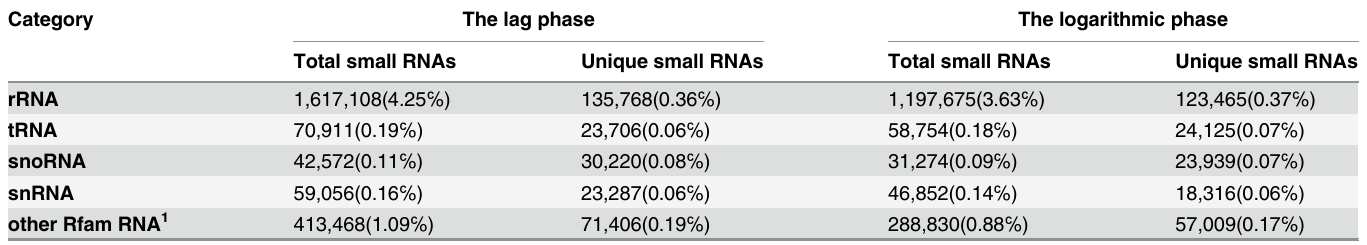
Table 2. Distribution of small RNAs among different RNA categories in A . catenella by mapping to Rfam database.